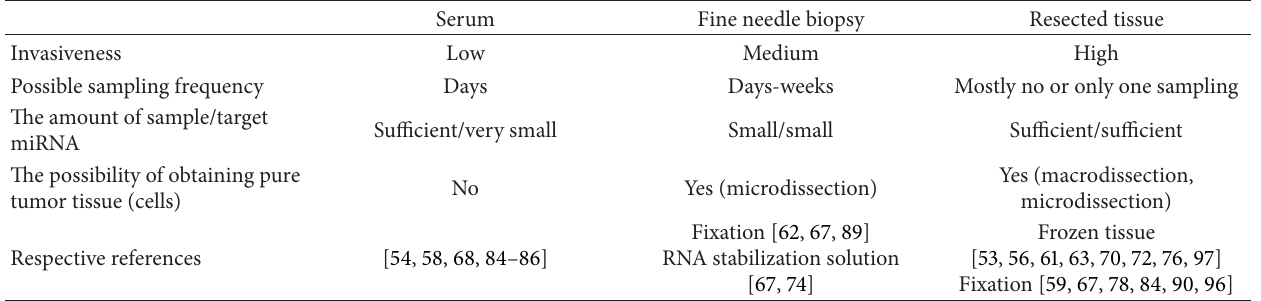
Table 4: Types of samples used for miRNA analysis in pancreatic cancer.